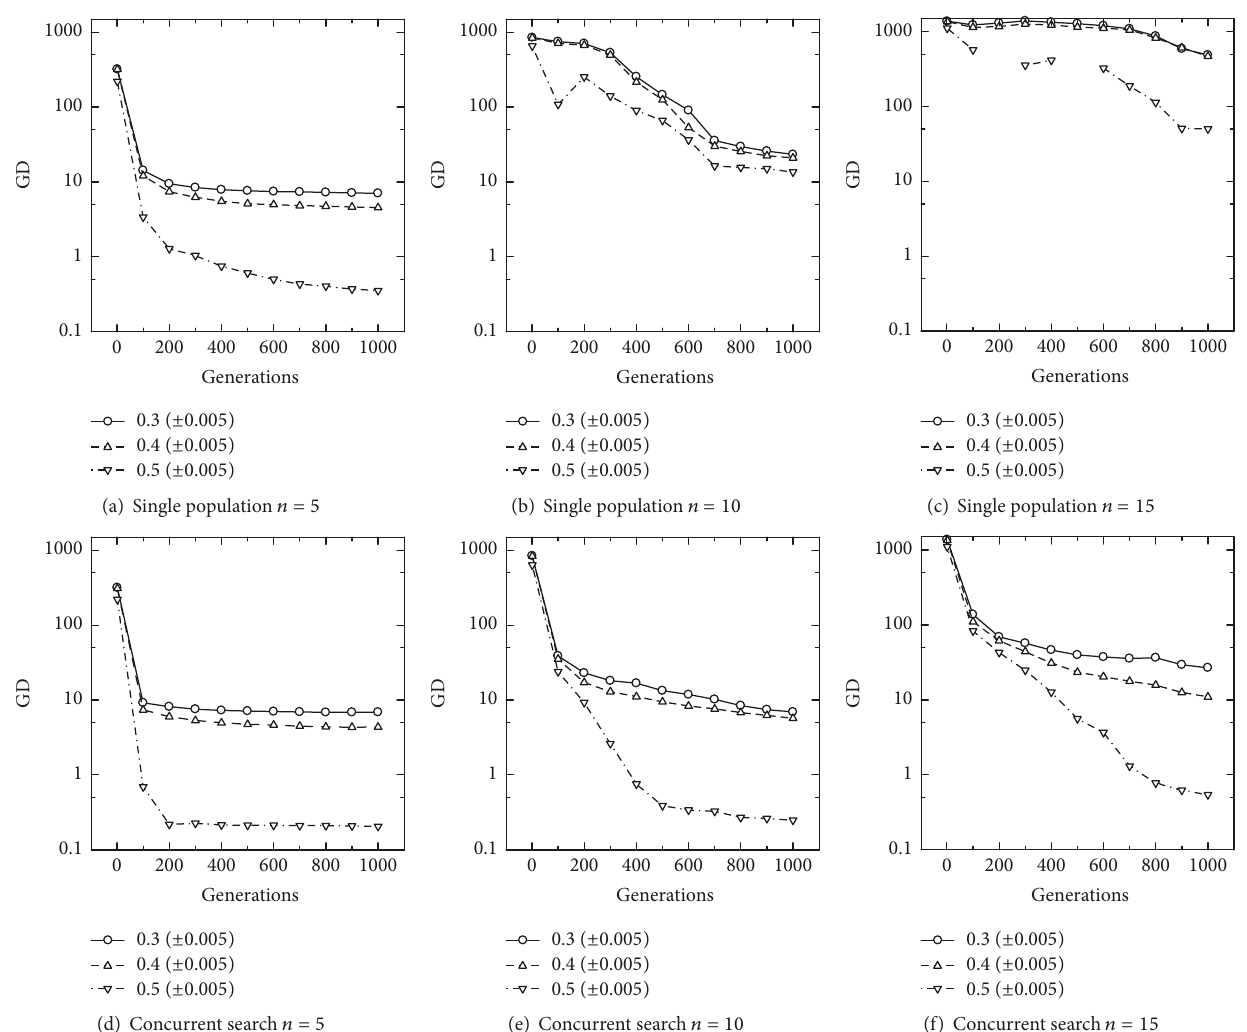
Figure 8: GD over the generations by single population method and proposed concurrent search method. DTLZ3, 𝑚 = 2 original objectives, 𝑀 = 4 objectives in the extended space, and 𝑛 = {5,10, 15} variables. GD is calculated separately grouping solutions into three groups according the preferred values 𝑥 5 = 0.3 , 𝑥 5 = 0.4 and optimal value 𝑥 5 = 0.5 . Solutions are considered within a group if 𝑥 5 = 0.3 ± 0.005 , 𝑥